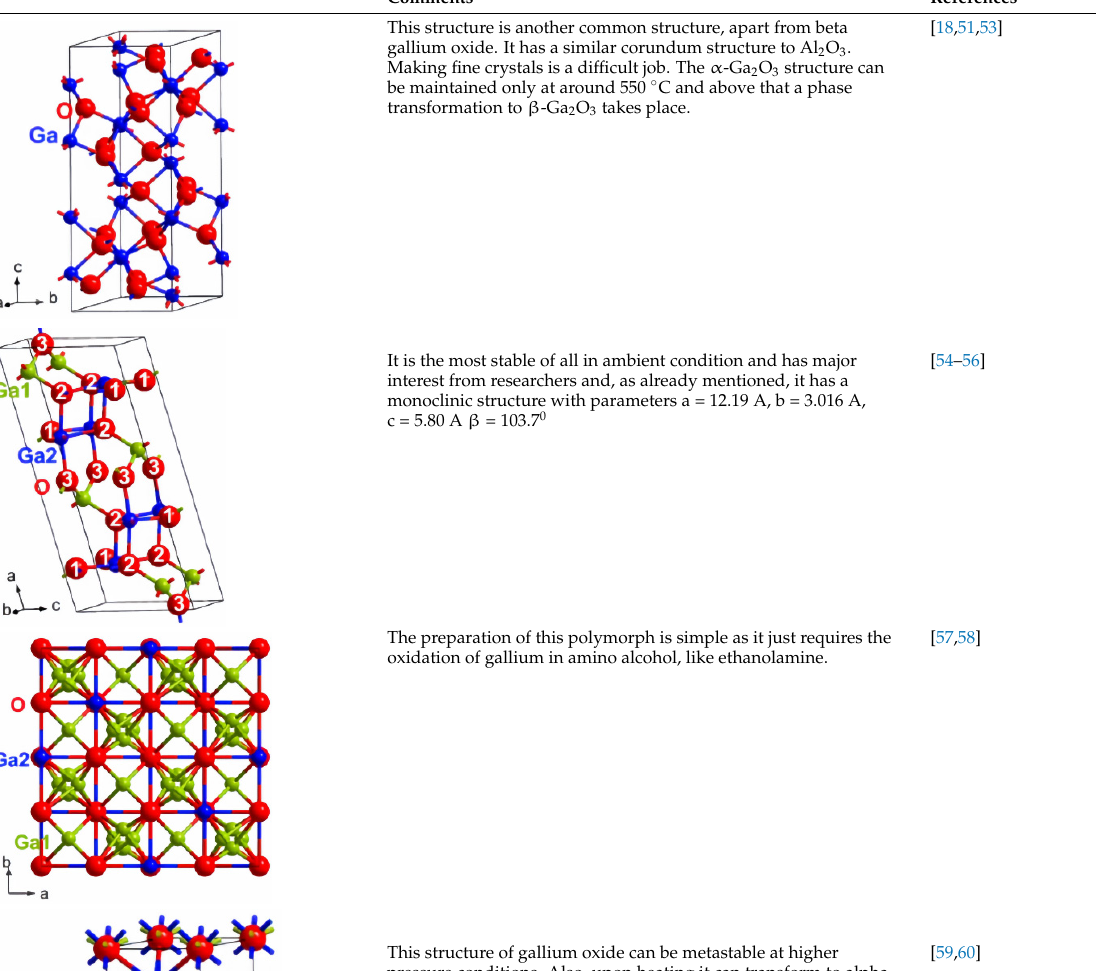
Figure 2. transformation of Gallium oxide polymorphs to β -Ga 2 O 3 [52]. “Reprinted with permission from Ref. [52]. Copyright (1952), ACS Publications”. Table 1. Polymorphs of Gallium Oxide. Table 1. Polymorphs of Gallium